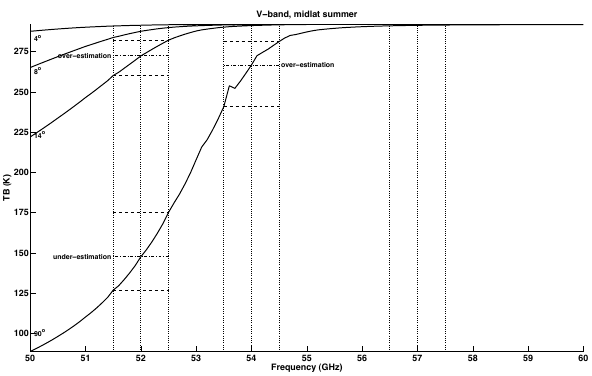
Fig. 7. Explanation of over and under estimations that cause the Figure 7. Explanation of over and under estimations that cause the bandwidth errors, which 5 bandwidth errors, which are linked to the curvature of the TB are linked to the curvature of the TB vs frequency curve in V-band for the mid-latitude 6 vs. frequency curve in V-band for the mid-latitude summer sound- ing. The vertical dotted lines represent the 1GHz bandwidth (centre summer sounding. The vertical dotted lines represent the 1GHz bandwidth (center line is 7 line is centre frequency). The short horizontal dashed lines are used center frequency). The short horizontal dashed lines are used to locate the intersection of the 8 to locate the intersection of the extremities of the bandwidth and extremities of the bandwidth and the dashed dot line locates the center frequency on the TB 9 the dashed dot line locates the centre frequency on the TB curve. curve. These additional lines help to visually see that the over-estimation and under-10 These additional lines help to visually see that the over-estimation estimation errors are linked to the curvature of the TB curve. 11 and under-estimation errors are linked to the curvature of the TB curve.